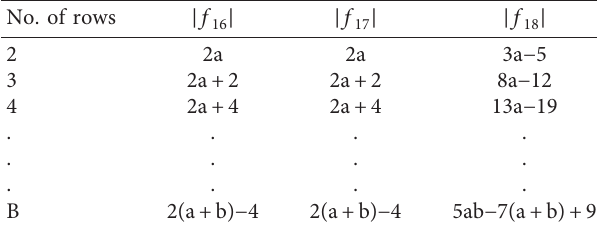
, f , and f with given number of 16 17 18